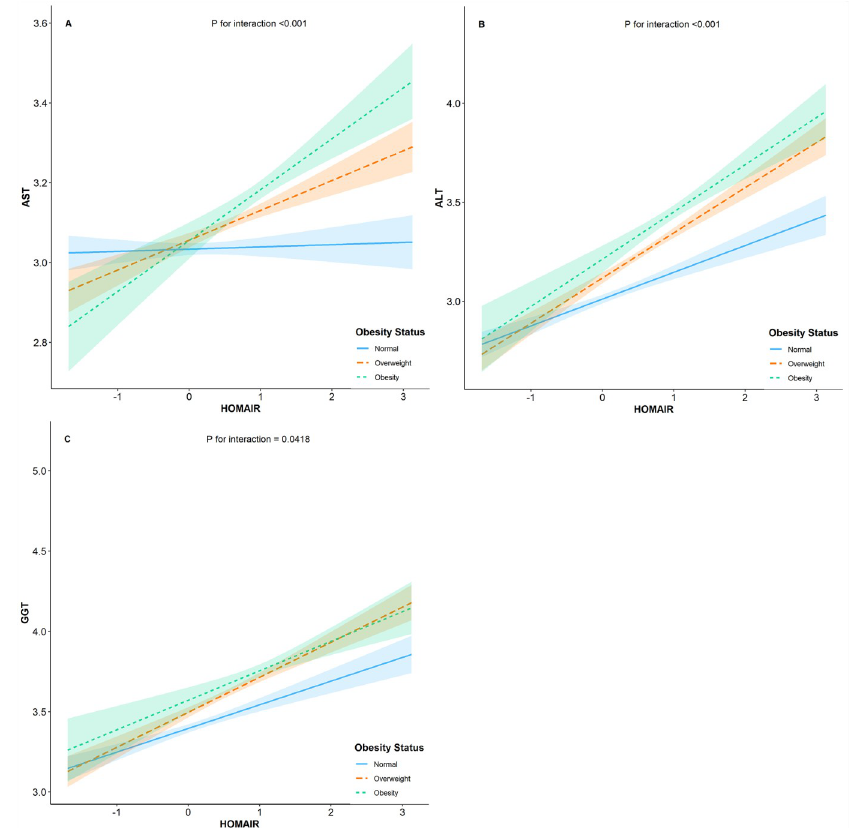
Fig 1. Interaction between weight status and HOMA-IR on liver